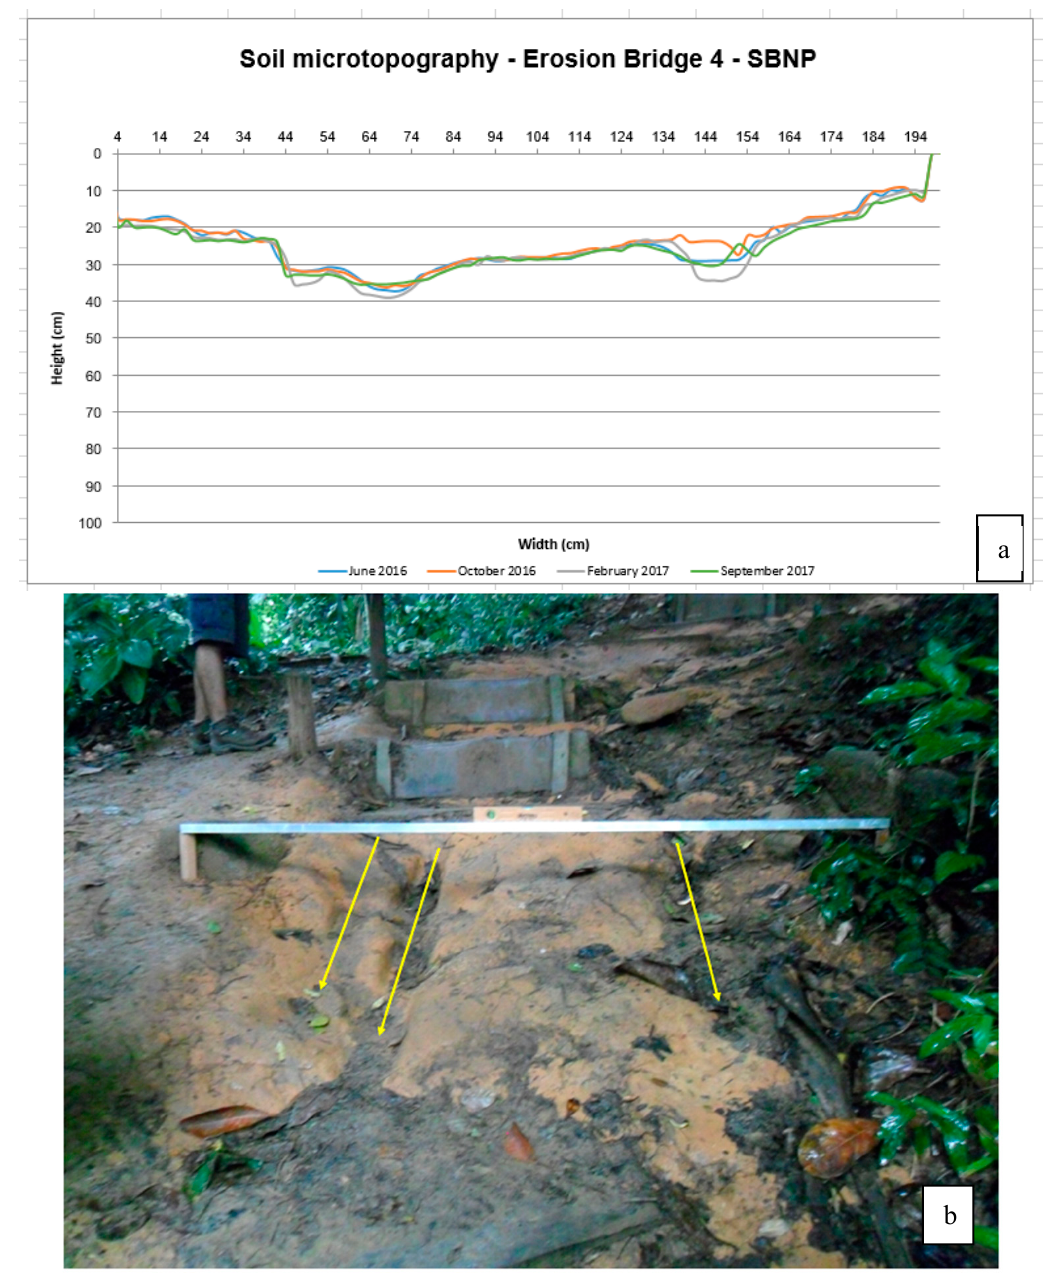
Figure 8. ( a ) Soil microtopographic analysis between June 2016 and September 2017 on EB4. ( b ) The yellow arrows indicate rills partially infilled by plant litter. Photo L. Rangel (2017). Table 1. Estimated area (m 2 ) of eroded soils on the SBNP trails.